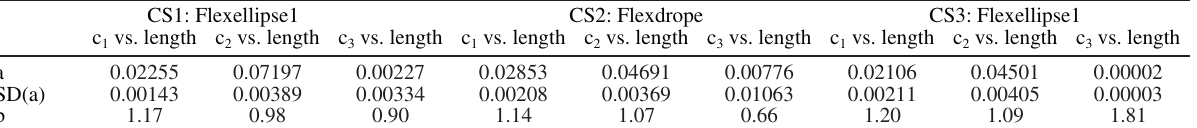
Table 4. – Functions in terms of length for the three parameters used to describe CS1, CS2 and CS3. All models are power models, as for example (see Herrmann et al. 2009 for details). Input for length is in mm. Output for c are in Appendix A in Tokaç et al. (2016). SD denotes standard deviation.